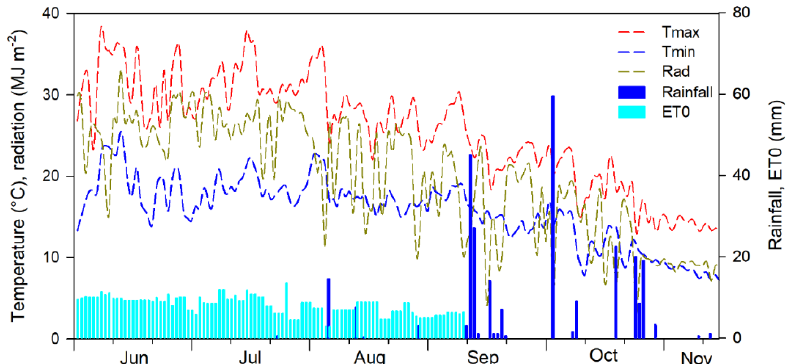
Figure 1. Meteorological trend (air temperature, global solar radiation, rainfall, and reference evapotranspiration) through the growing season at the experimental site (37° 23 ′ N Lat., 14° 21 ′ E Long., 550 m a.s.l.).